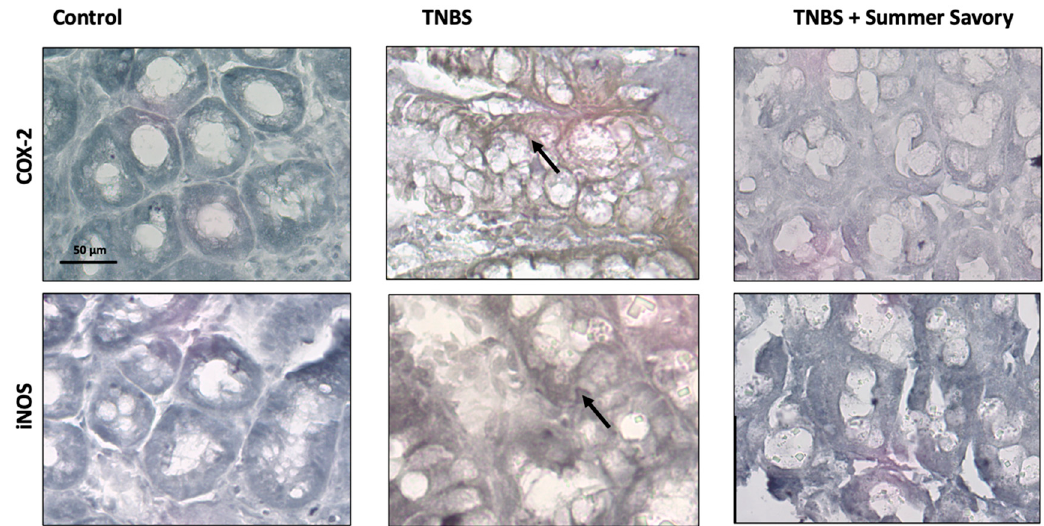
Figure 9. Evaluation of COX-2 and iNOS expression in the colitis model revealed that specimens from the TNBS colitis group exhibited severe expression of COX-2 and iNOS (brown staining, arrow), while specimens from the treated animals with Savory showed no expression of COX-2 and iNOS. Sham Group ( n = 6); EtOH Group ( n = 6); TNBS + EtOH Group ( n = 10); TNBS + Summer Savory Group ( n = 10). Original magnification ×100. Scale bar equals 50 µm.